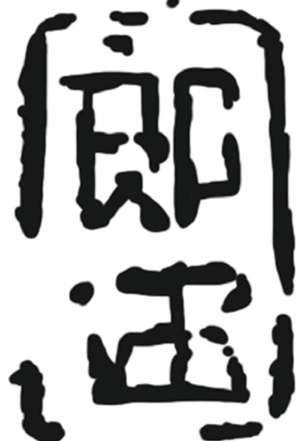
Figure 34. A round bronze seal carved with a Jurchen character excavated in Zhongxing City, Heilongjiang. The Jin Dynasty. Picture source: The Heilongjiang Provincial Archaeological Research Team (1977), p. 45.